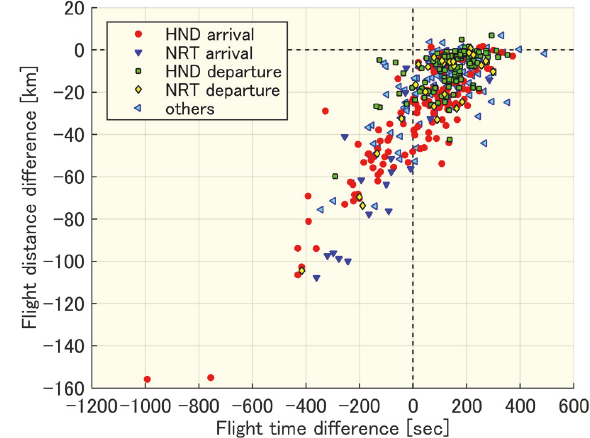
Figure 9: Flight distance difference of the optimal trajectories relative to the original flights